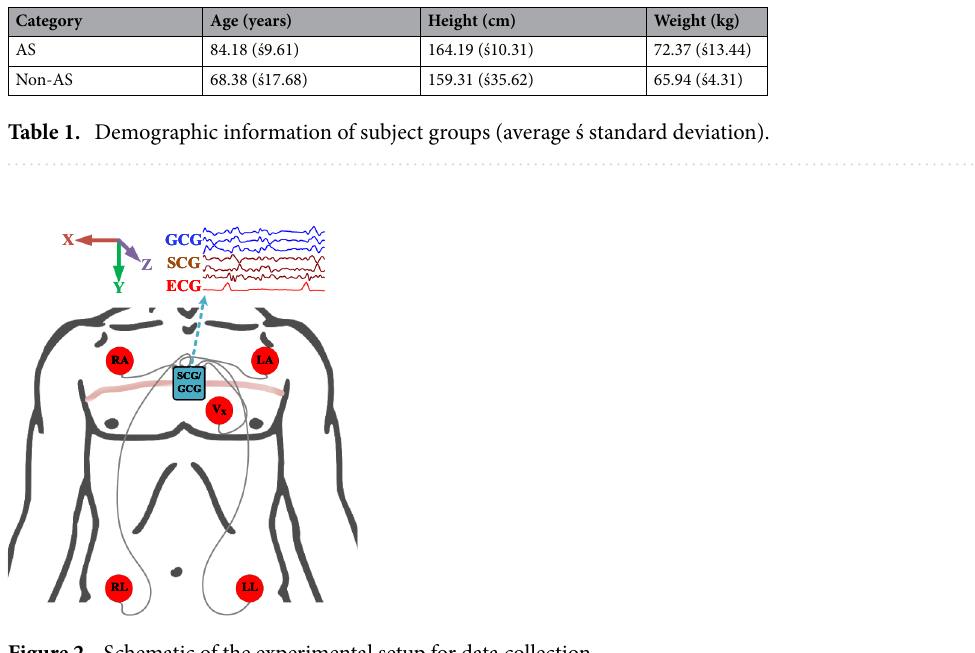
Figure 2. Schematic of the experimental setup for data collection.